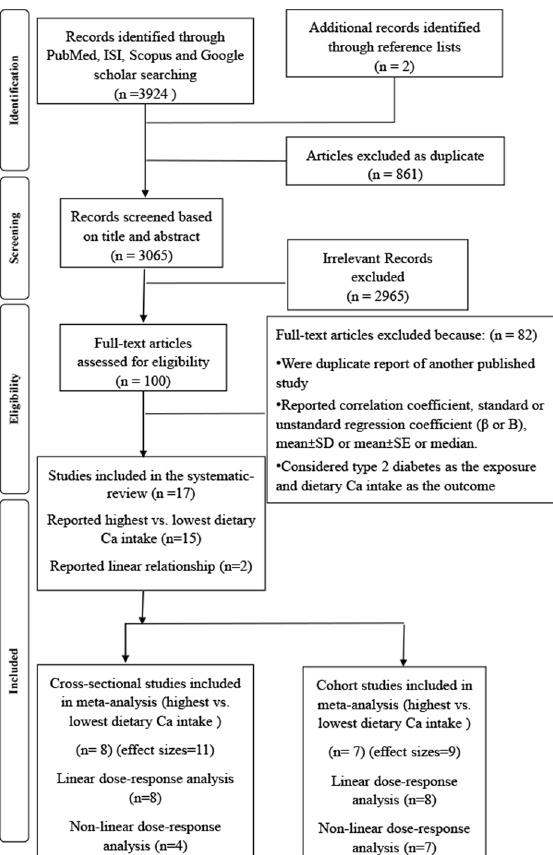
Figure 1. Flow diagram of search strategy and study